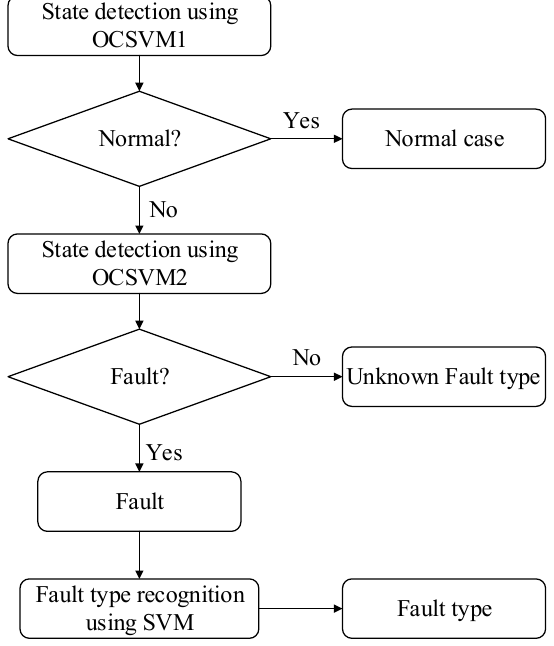
Figure 9. Fault diagnosis process.